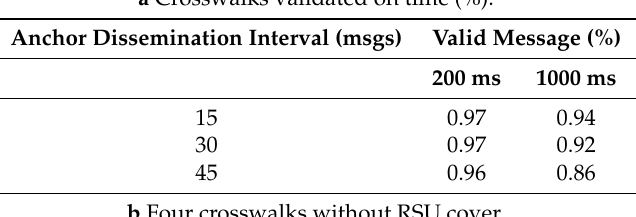
Table 5. Validated message percentage. a Crosswalks validated on time